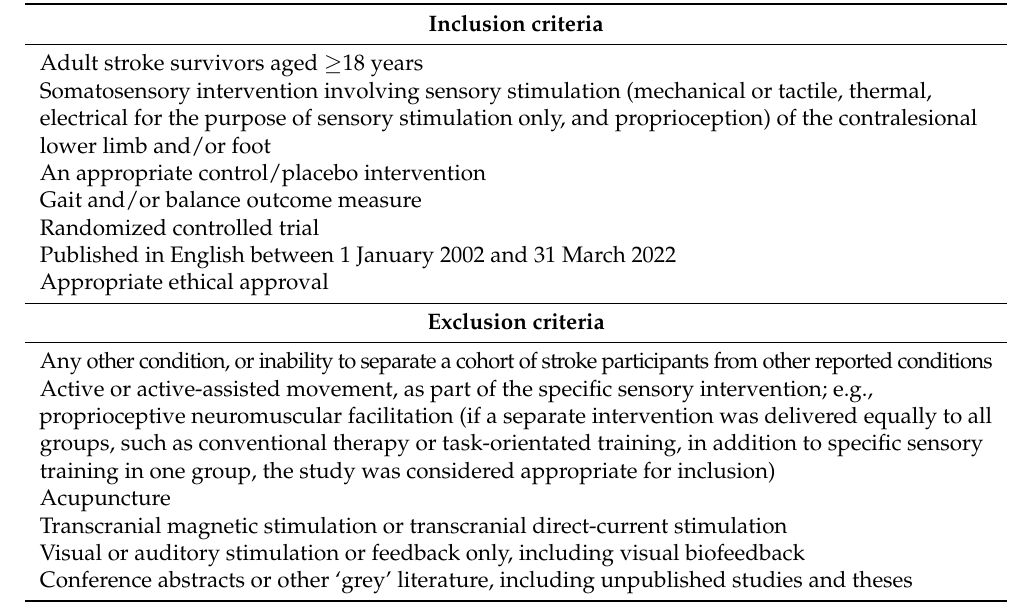
Table 2. Inclusion and exclusion criteria for the systematic